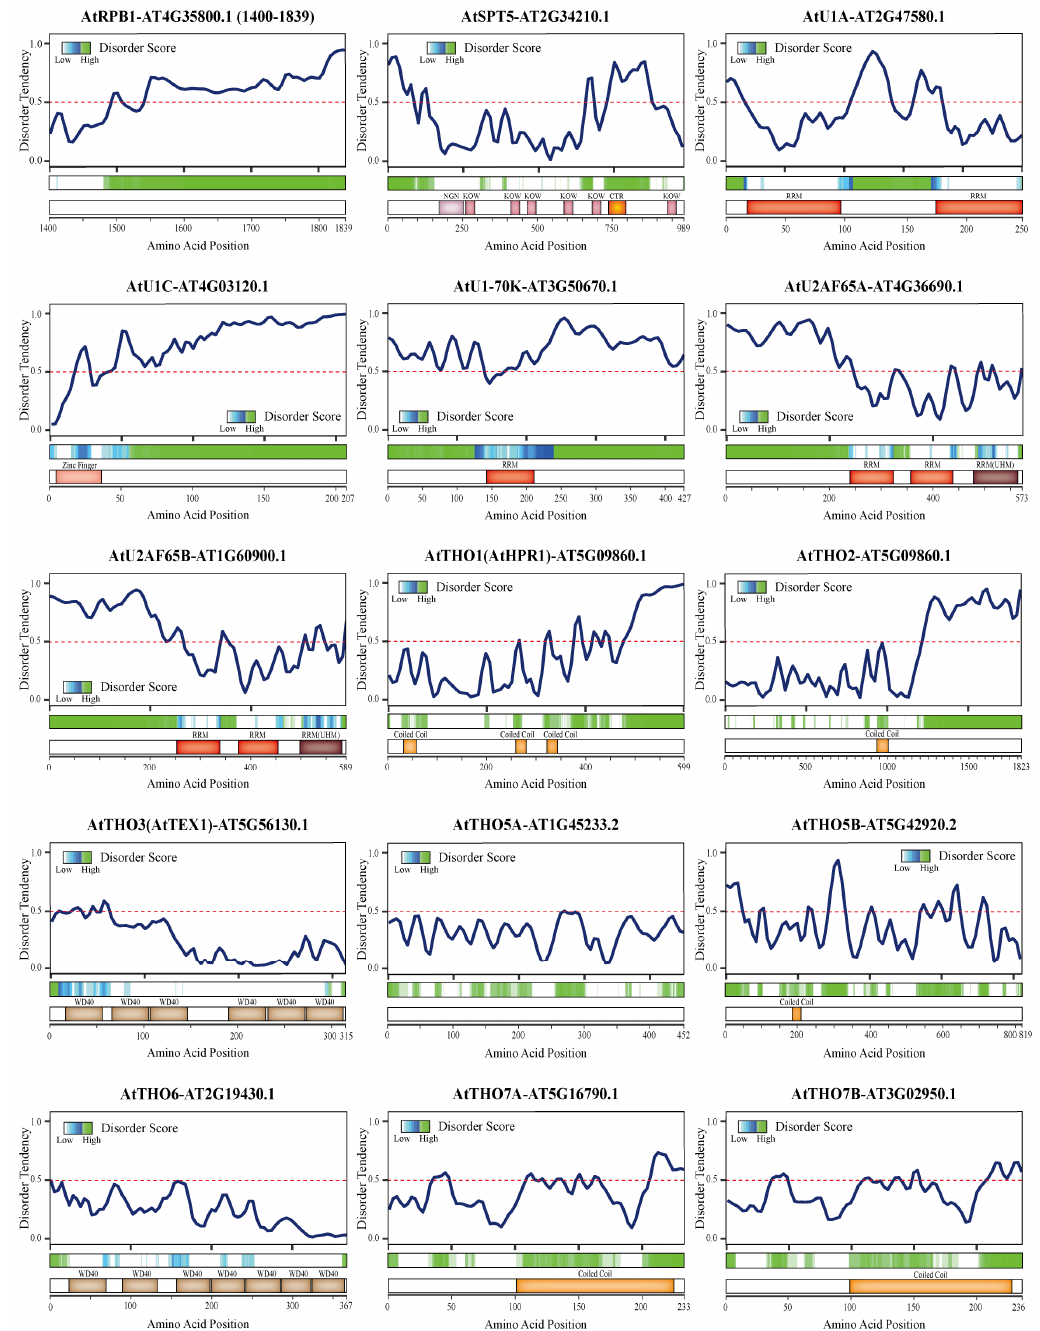
Figure 2. Disorder tendency predictions for proteins involved in the coupling of transcription and RNA processing in plants. All protein sequences were downloaded from TAIR (https://www.arabidopsis.org/ (accessed on 6 November 2020)). (For each figure, top panel ) Protein disorder tendency curve. The disorder tendency score of each amino acid was predicted using IUPred2A [134] and subsequently fit to a smooth curve using the R ggplot2 package. The predicted scores were between 0 and 1, with a score above 0.5 (dashed line) indicating disorder. (For each figure, middle panel ) Prediction of disordered regions using D 2 P 2 [135]. (For each figure, bottom panel ) A domain map of the proteins in Arabidopsis based on previous studies [81,88] and the protein databases UniPro [136], Pfam [137], and SMART [138]. The disorder predictions for full-length proteins, except for AtRPB1 (C-terminal domain), are displayed. Abbreviations: WD40, tryptophan-aspartic acid motif repeats; RRM, RNA recognition motif; UHM, U2AF homology motif; NGN, NusG N-terminal domain; KOW, Kyrpides–Ouzounis–Woese motif; CTR, C-terminal repeat